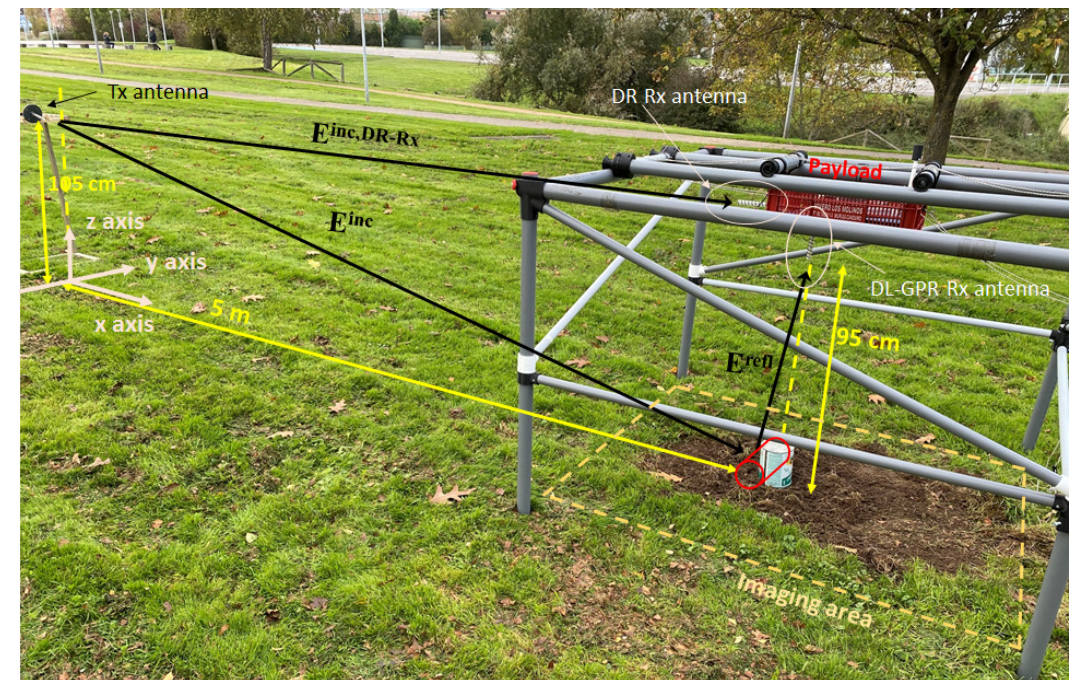
Figure 5. Picture of the implemented FLGPR-DLGPR system. Tested target: metallic can (the profile of the metallic can when laid down is plotted in red color).